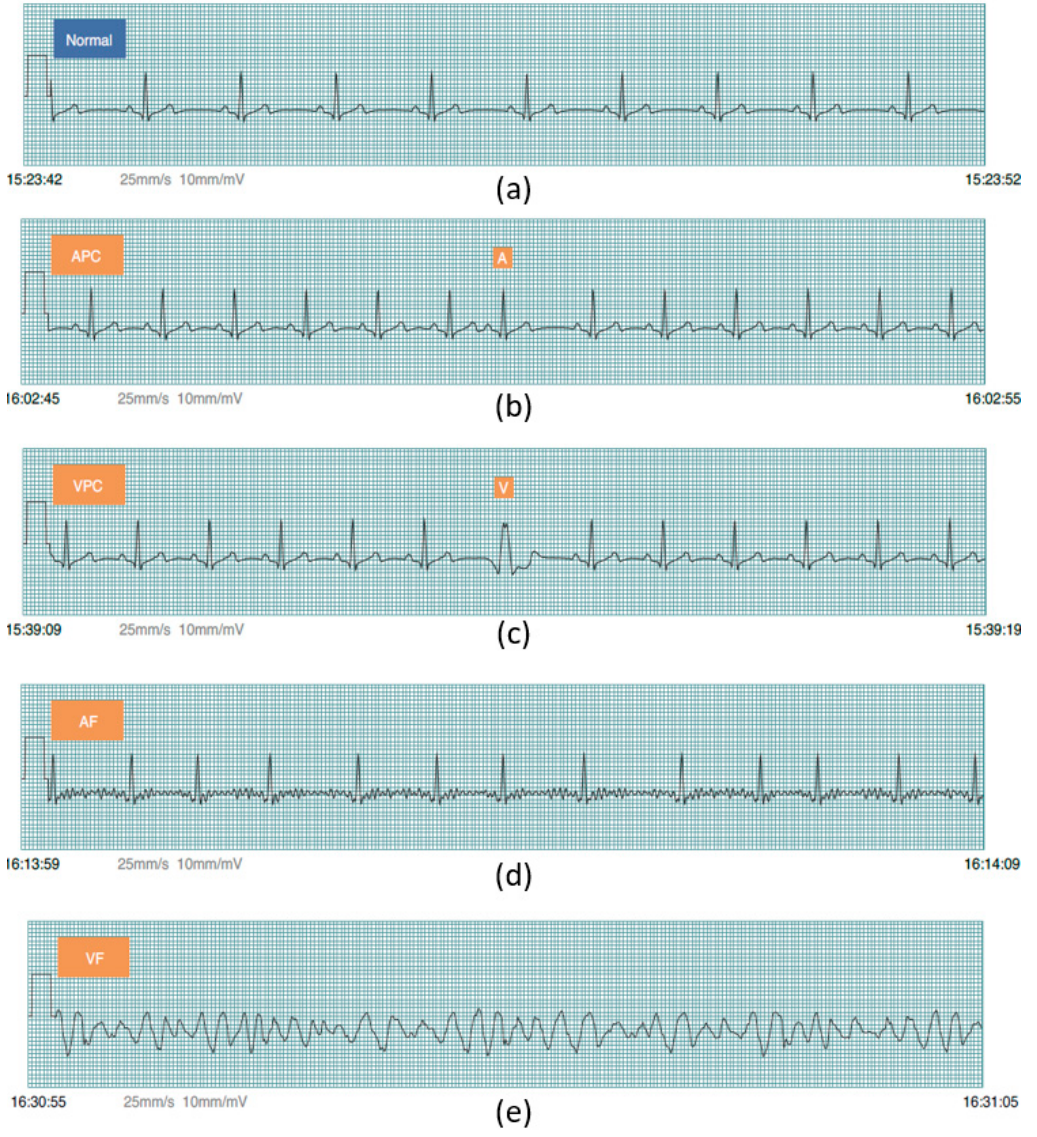
Figure 5. Documented simulation results from Fluke simulator; ( a ) Normal sinus rhythm; ( b ) Atrial Premature Complex (APC); ( c ) Ventricular Premature Complex (VPC); ( d ) Atrial fibrillation; and, ( e ) Ventricular fibrillation.